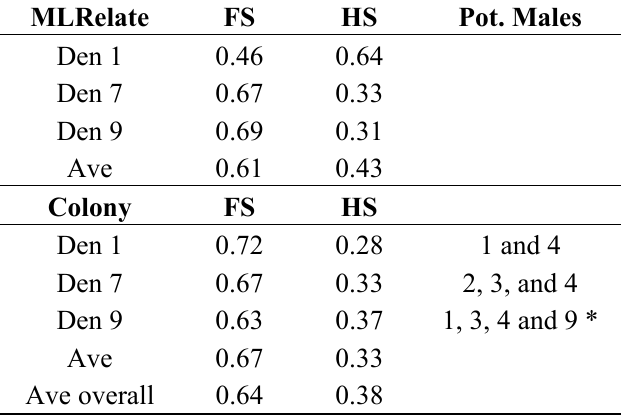
Table 3. Proportional relatedness among eggs sampled at three octopus dens (1 =